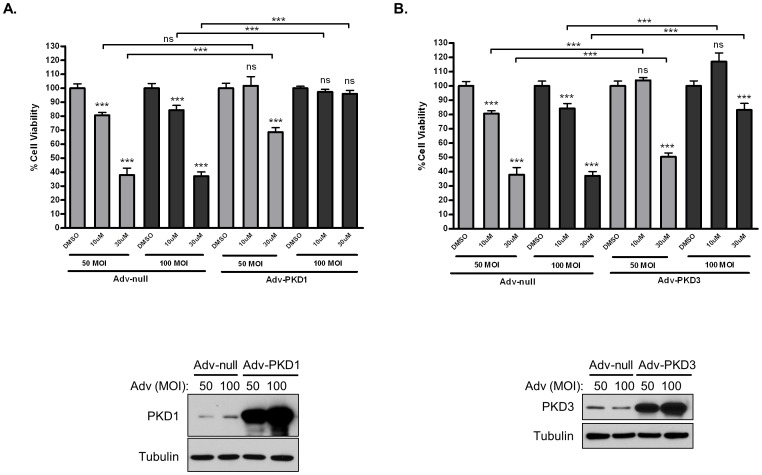
1-NA-PP1-induced growth arrest was mediated through targeted inhibition of PKD.Overexpression of PKD1 and PKD3 in prostate cancer cells rescued the anti-proliferative effects of 1-NA-PP1. PC3 (0.5 million) cells were seeded in a 60 mm dish and infected the next day with 50 and 100 MOI adenoviruses carrying PKD1 (Adv-PKD1) (A) and (Adv-PKD3) PKD3 (B). Empty adenovirus (Adv-null) was used as control. After 24 h, 3000 cells/well were plated in 96-well plates and treated with and without 10 and 30 µM 1-NA-PP1 for 72 h. MTT solution was added to each well and incubated for 4 h. Optical density was read at 570 nm to determine cell viability. The overexpression of PKD1 and PKD3 was confirmed by Western blotting analysis (images below the graphs). Statistical significance between DMSO and inhibitor treatment for each adenovirus as well as between control and PKD adenoviruses at each inhibitor concentration were determined by unpaired t-test in GraphPad Prism V. ns, not statistically significant; *, p<0.05; **, p<0.01; ***, p<0.001